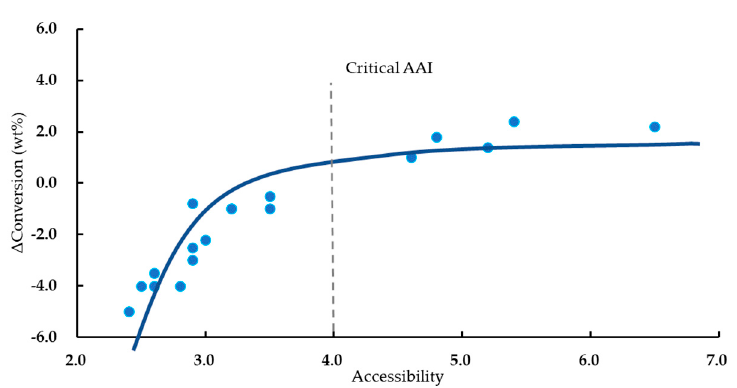
Figure 10. Effect of FCC accessibility on conversion.